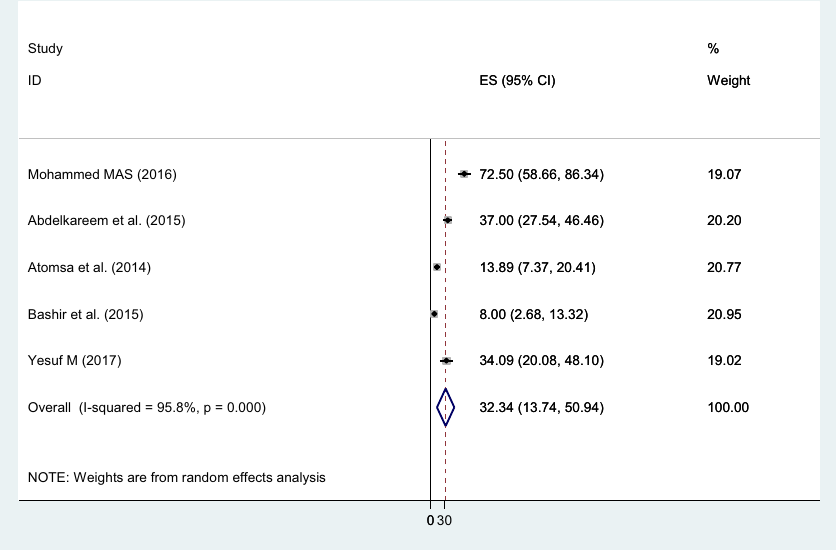
Figure 7. The pooled prevalence of normocytic normochromic anemia at TB diagnosis.